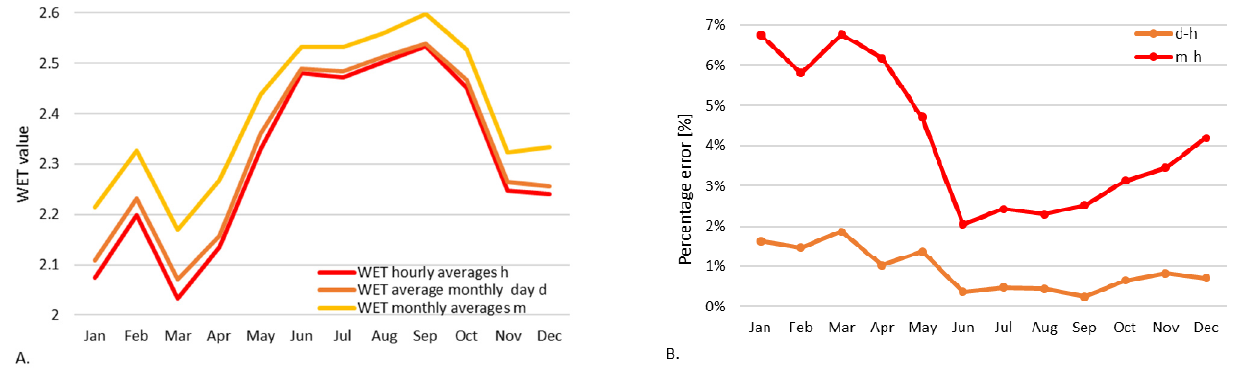
Figure 4. Havana, t and r.h. during the average year.